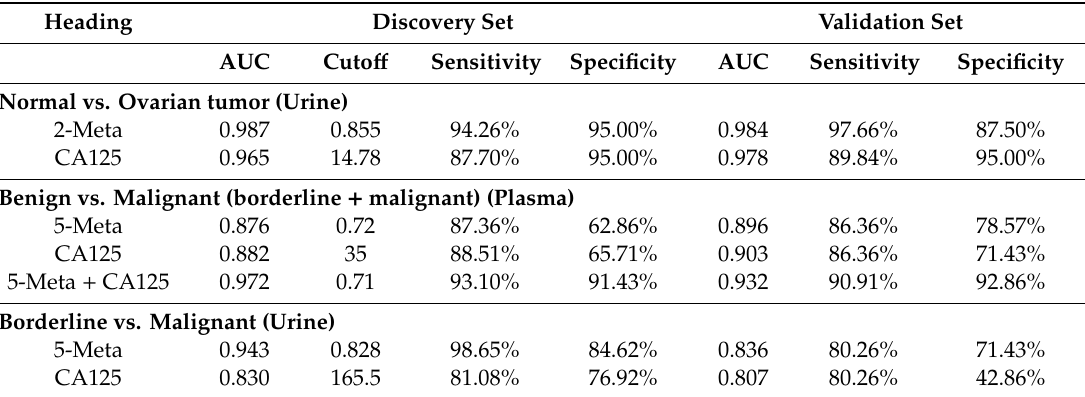
Table 3. Results of measurement of the putative metabolite panel, CA125 or Both in the diagnosis of ovarian tumor or ovarian cancer.